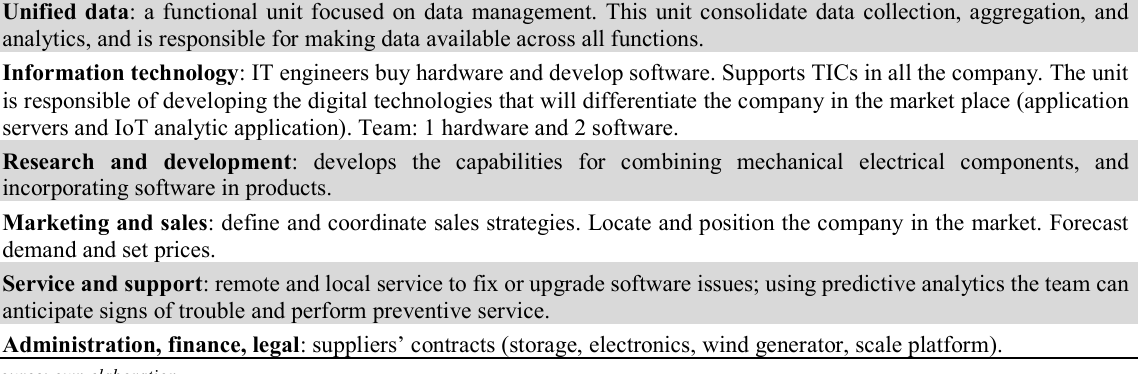
Areas in the smart and connected products